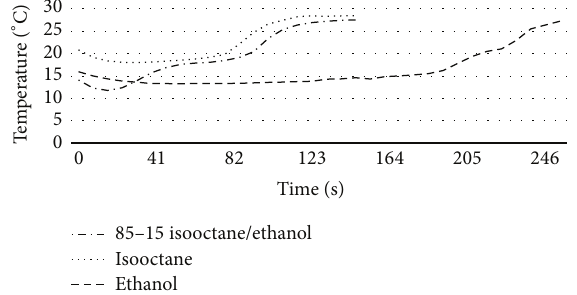
Figure 6: Droplet evaporation by suspension from a thermocouple and the corresponding thermocouple measurements over time.